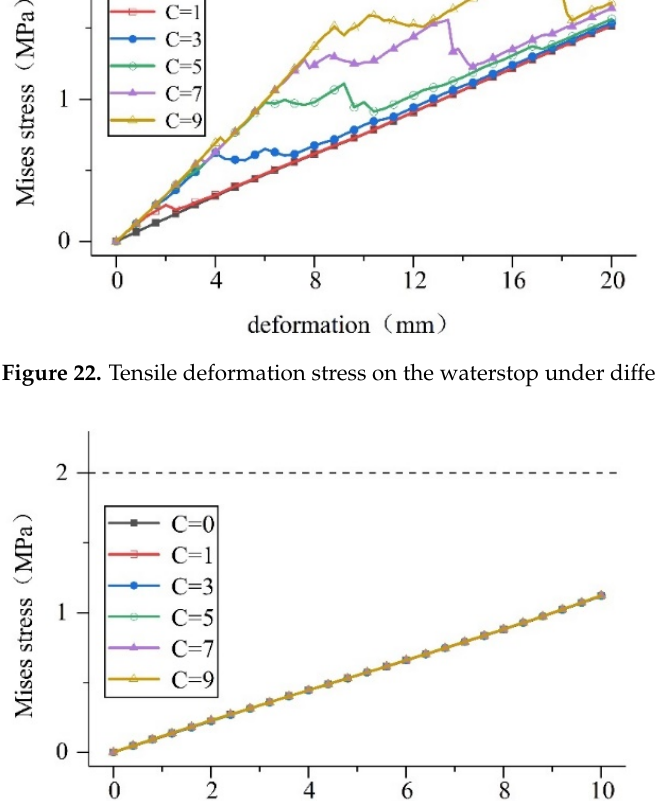
Figure 23. Compression deformation stress on the waterstop under different bonding force conditions.